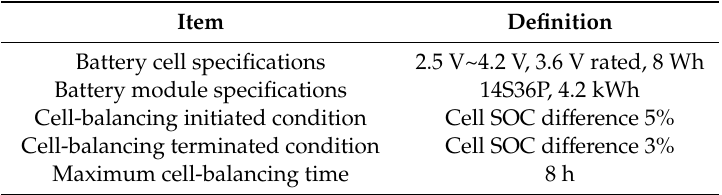
Table 4. Cell-balancing criteria for the battery module.